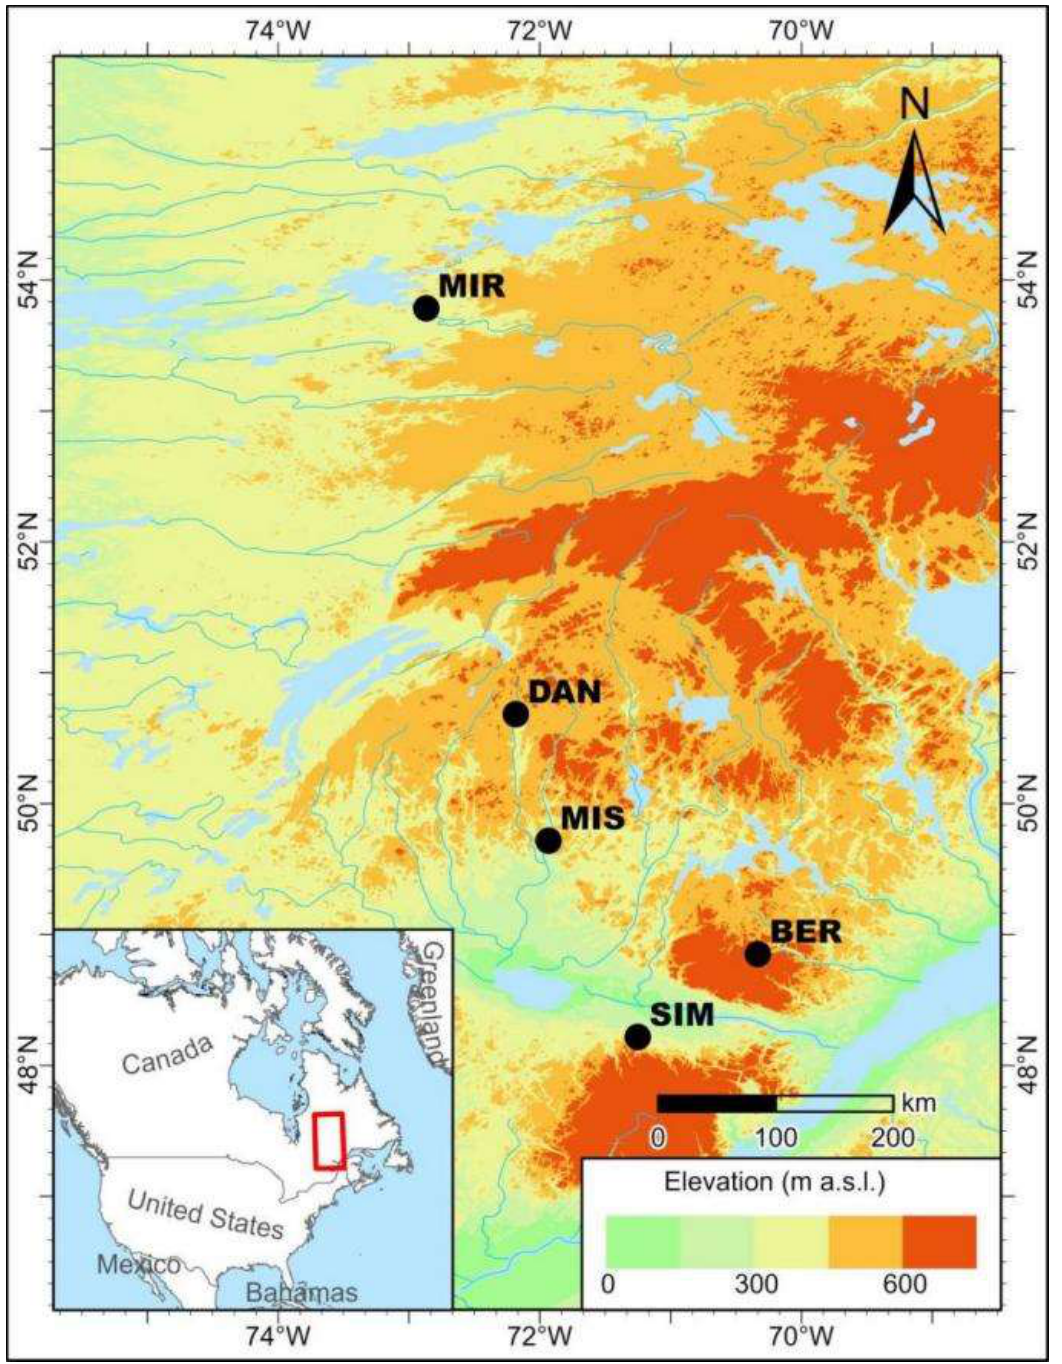
Figure 1. Locations of the five permanent sites in the boreal forest of Quebec, Canada.